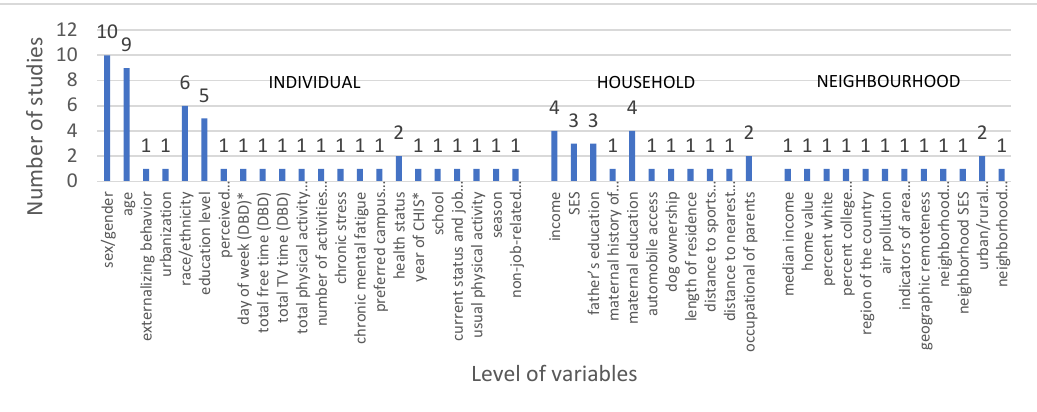
Figure 2. Covariate, confounders, moderators and mediators.